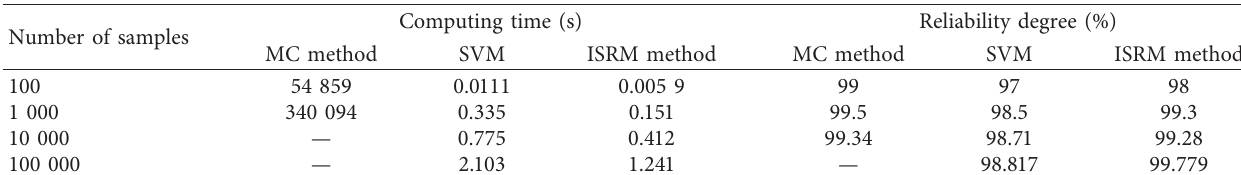
Table 4: Computing time and reliability degrees of blade probabilistic analysis with different methods.